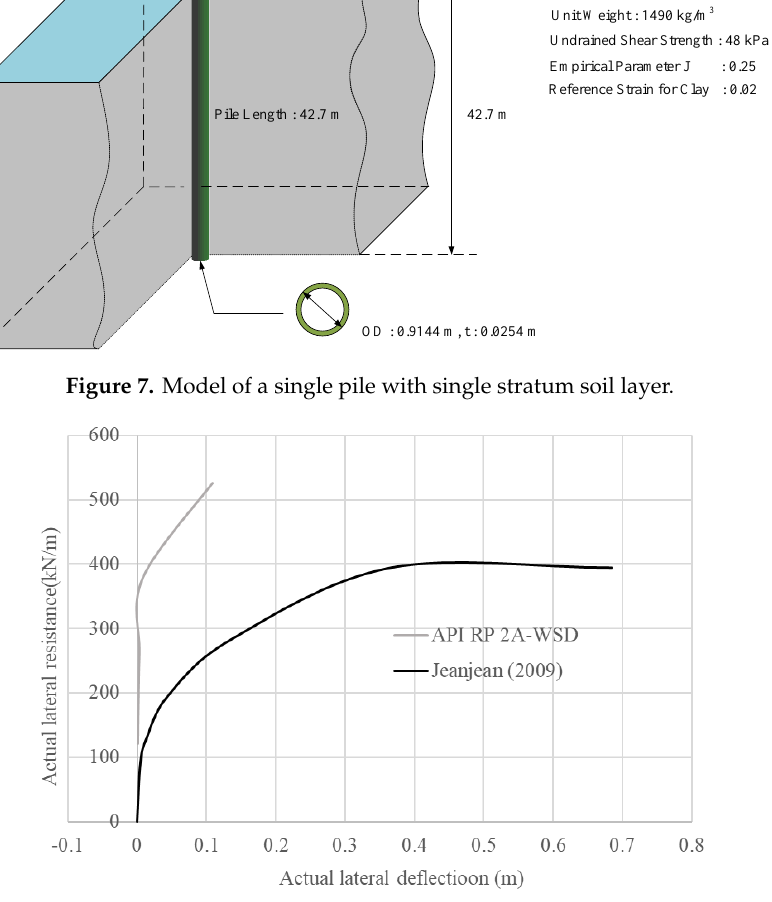
Figure 8. Loads corresponding to the deflection (P–Y curve).